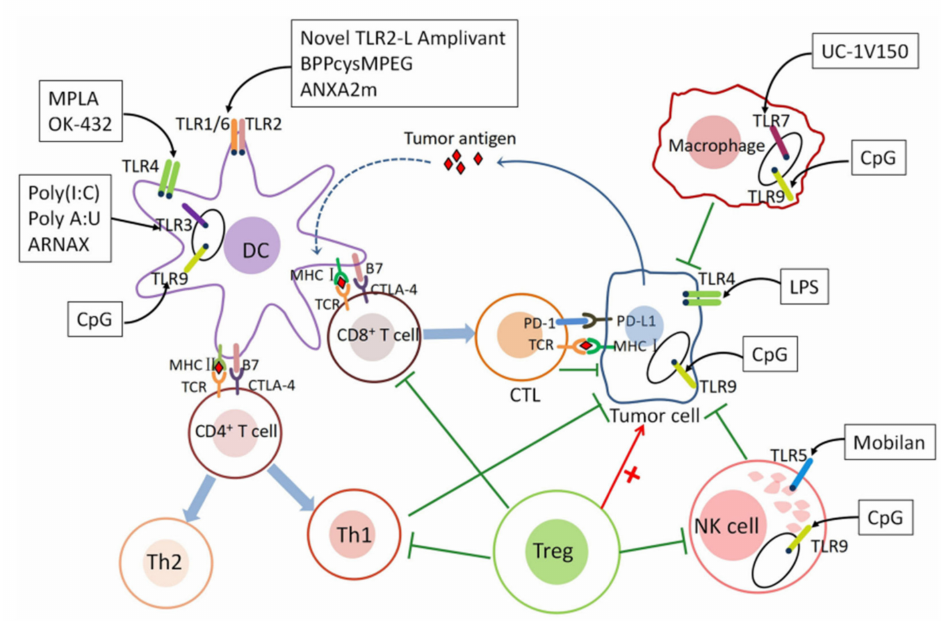
Figure 3. Scheme of TLR agonist-mediated signaling cascades in tumor immunity and immune check point pathways. Reproduced with permission from ref. [50]. 2020